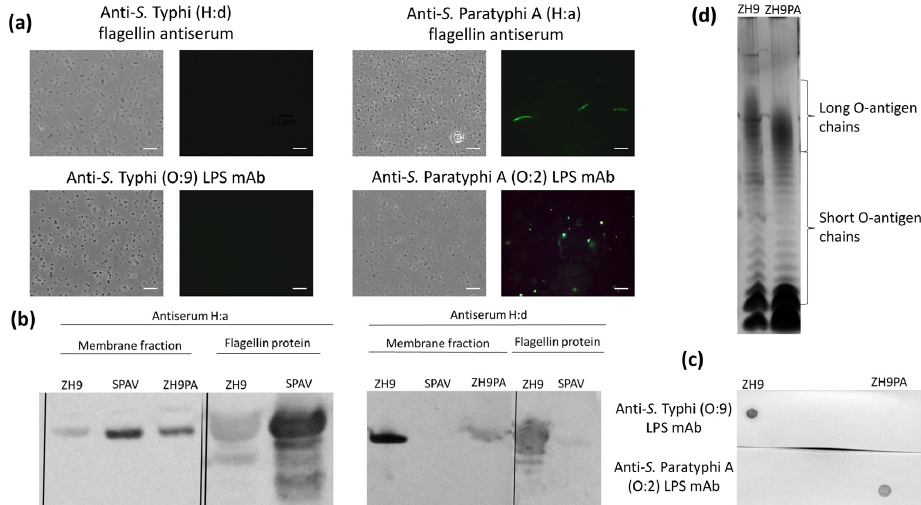
Figure 3. Converting flagellin and LPS in the final new strain, ZH9PA. ( a ) Fluorescence microscopy images showing the S. Typhi ZH9 derivative strain, ZH9PA, probed with anti- S . Typhi (H:d) or anti- S . Paratyphi A (H:a) flagellin antiserum and anti- S. Typhi (O:9) or anti- S. Paratyphi A (O:2) LPS mAbs; the left images are phase contrast images and right images are immuno-fluorescence micrographs. Images were taken at 100× magnification. Scale bars represent 10µm. Representative images based on three independent experimental repeats. ( b ) Western blots of membrane fractions probed with anti- S. Typhi (H:d) or anti- S. Paratyphi A (H:a) flagellin antisera using ZH9 or SPAV as positive controls, respectively. Purified flagellin proteins were also included as a positive control. ( c ) Dot blot probed with anti- S. Typhi and anti- S. Paratyphi A LPS mAbs. ( d ) Silver-stained polyacrylamide gel of LPS preparations from S. Typhi ZH9 and derivative strains, ZH9PA, indicating the short and long O-antigen chains. LPS = lipopolysaccharide; mAb = monoclonal antibody; SPAV = attenuated S. Paratyphi A.